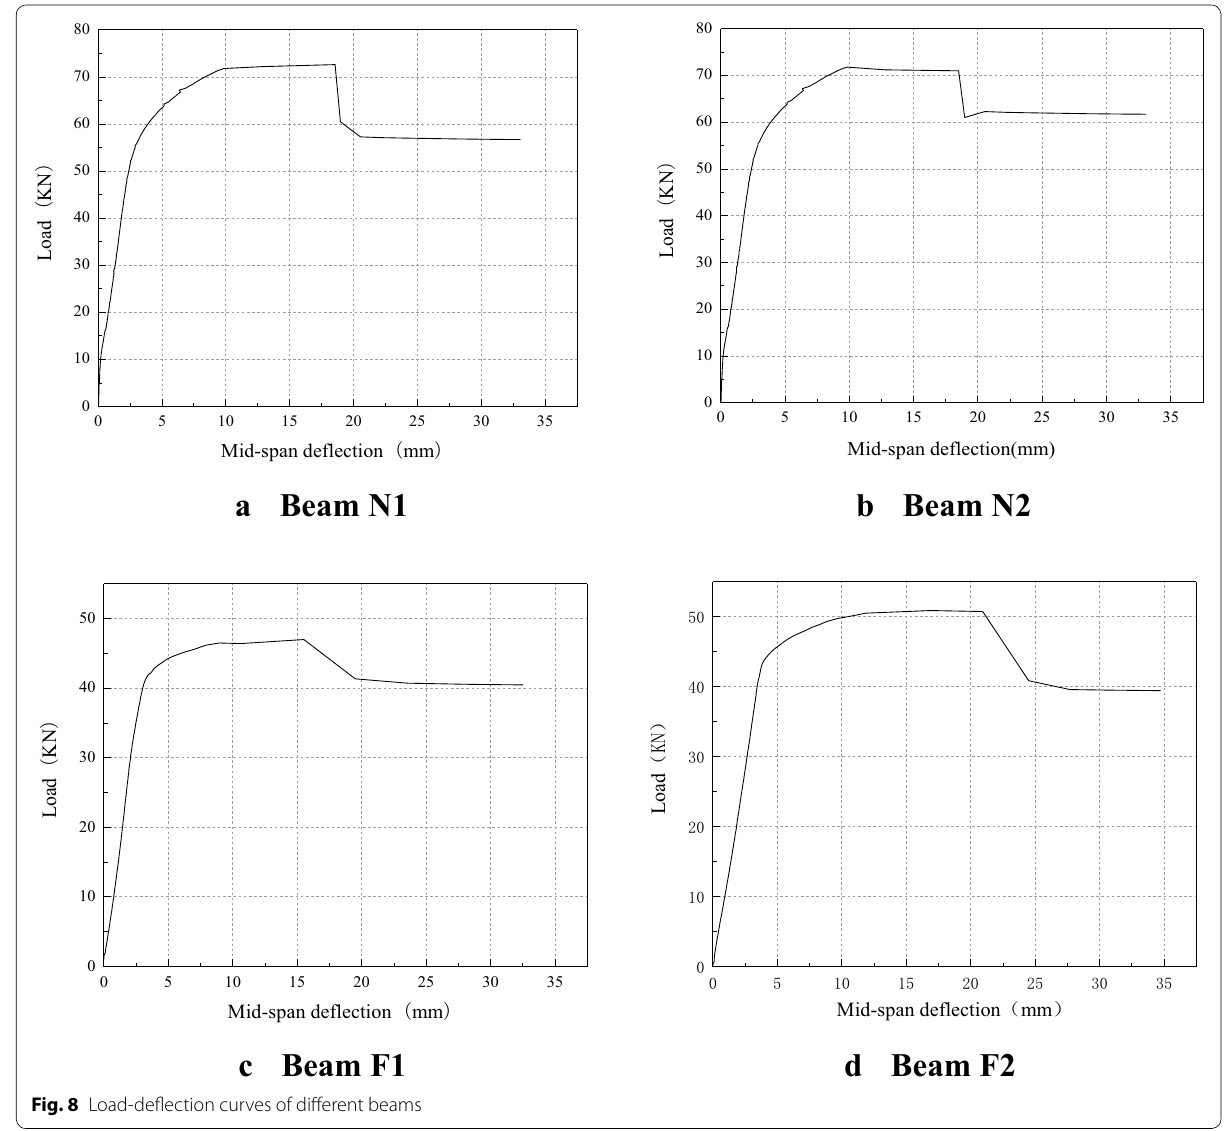
Fig. 8 Load-deflection curves of different